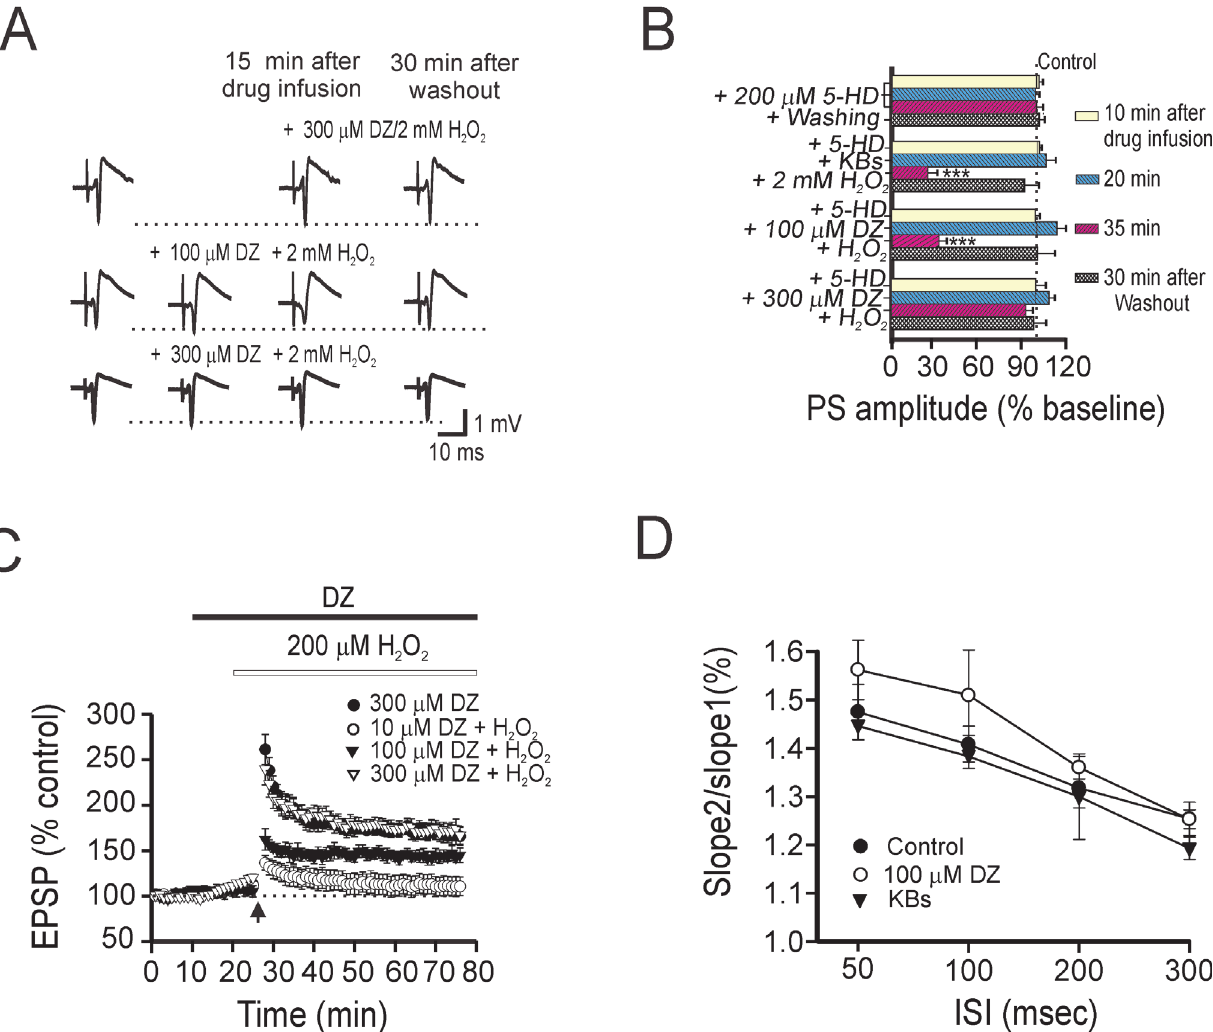
Fig 2. Diazoxide mimics the synaptic effect of ketones. (A) Representative traces of DZ (100 μ M or 300 μ M) with 2 mM H 2 O 2 on the CA1 hippocampal PS, demonstrating the dose-dependent synaptic protective effects of DZ. Partial protection was seen with H 2 O 2 exposure following a 10 min pre-incubation with 100 μ M DZ ( middle ). No significant differences were found between the two groups (co-application vs . pre-incubation) compared to 300 μ M DZ. (B) Summary of PS amplitude changes (as % baseline) during or after drug application is shown in the bar graph. Each vertical bar indicates mean PS amplitude ± SEM, and was obtained in 12 slices from 5 rats. Asterisks denote significant differences between the 100 μ M DZ plus 2 mM H 2 O 2 group and other treatment groups ( ** , p < 0.01). (C) DZ protects synaptic impairment against oxidative stress. Representative traces of EPSPs at respective time- points (a, b, c) are depicted on the right. (D) Changes in paired-pulse facilitation at CA1 in hippocampal slices after 40 min infusion of physiological saline, KBs (a cocktail of BHB and ACA; each 1 mM) and 100 μ M DZ. Exposure to either KBs or DZ did not induce a significant change in presynaptic transmission following paired-pulse stimulation. The data was obtained in 7 slices from 4 mice. ISI indicated interstimulus